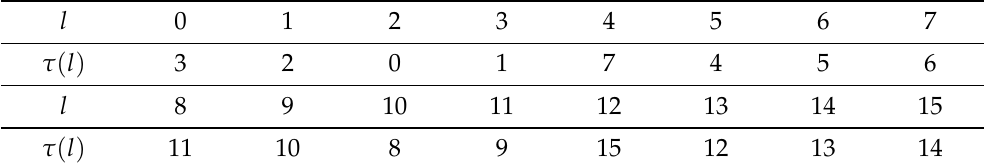
Table 4. Permutation table for the LSH expansion function.